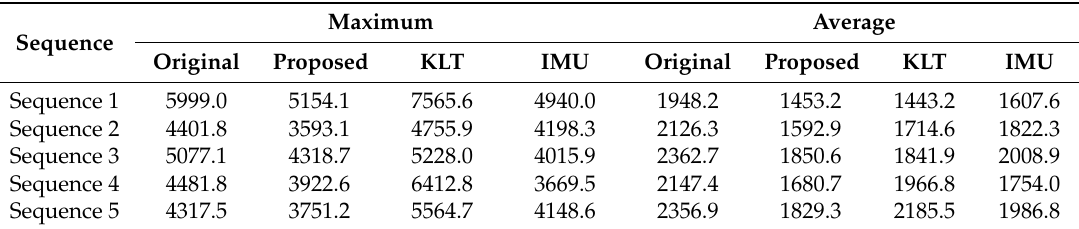
Table 4. Error of two consecutive frames by different motion estimation method.